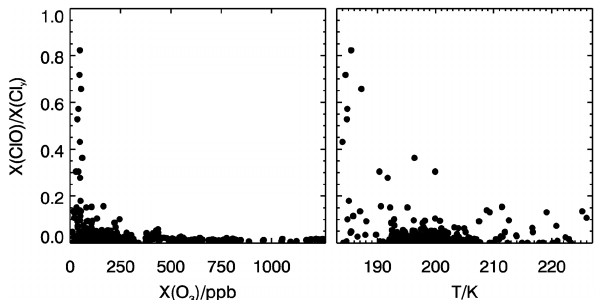
Fig. 4. Dependence of ClO/Cl y on temperature and O 3 at time of observation. X(ClO)/X(Cl y ) is calculated from HALOX ClO ob- servations and Cl y estimates as described in Sect. 2.1, so uncer- tainties in this quantity will be rather large. Nevertheless, observed enhancements compared to the typical gas phase ClO/Cl y ratios are significant for the majority of data points.